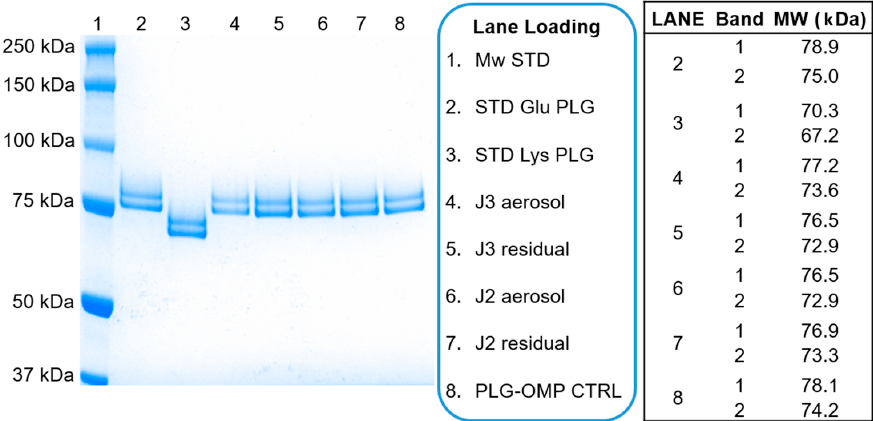
Figure 1. Lys-PLG SDS-PAGE represents 8% of the Bis-Tris gel of control and jet nebulized PLG-OMP samples. Stained gel, lane loading and bands Mw are reported from left to right,